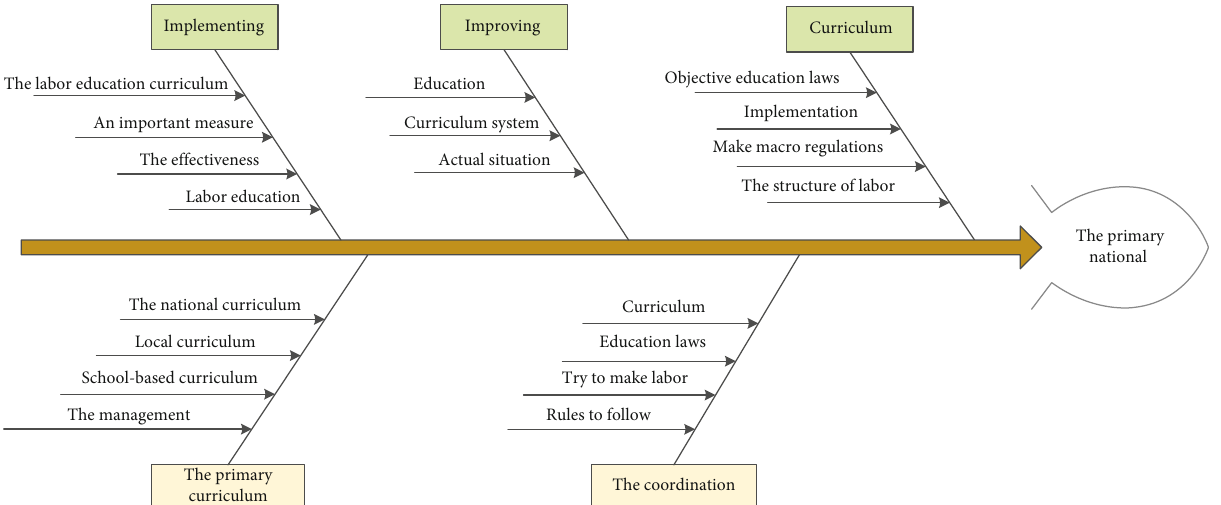
Figure 5: Structure of labor education in university